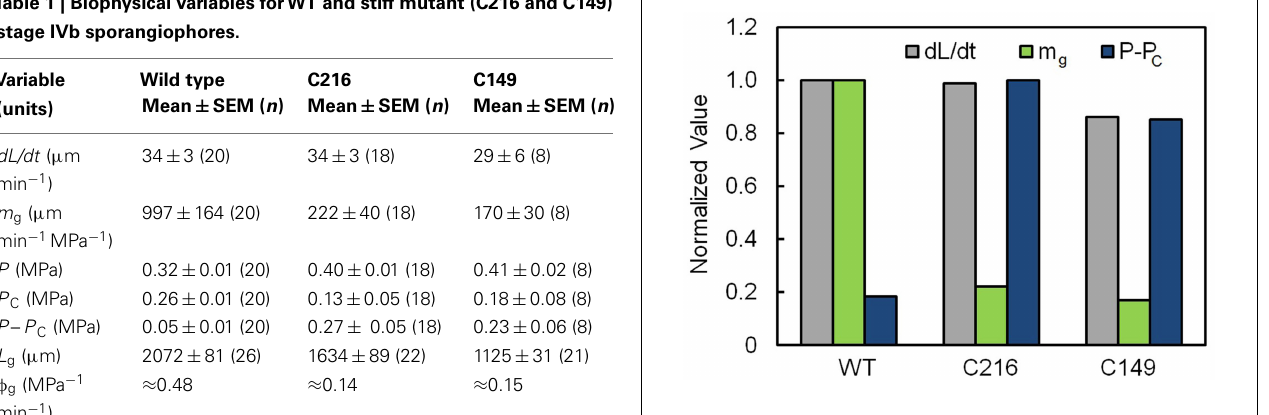
FIGURE 5 | Normalized values of dL/dt , m g , and ( P–P C ) for wild type and stiff mutant (C216 and C149) stage IVb sporangiophores. Normalized values for each variable are obtained by dividing the average values presented in Table 1 for wild type (WT) and stiff mutant (C216 and C149) stage IVb sporangiophores by the largest magnitude of the respective variable.The elongation rate, dL/dt (gray bars), ofWT and the stiff mutants stage IVb sporangiophores (C214 and C149) are statistically the same magnitude. Stiff mutant stage IVb sporangiophores have significantly smaller magnitudes for m g (green bars) and significantly higher magnitudes of P–P C (blue bars) compared to theWT.The higher magnitudes of P–P C compensate the smaller magnitudes of m g to achieve similar elongation rates exhibited byWT sporangiophores.